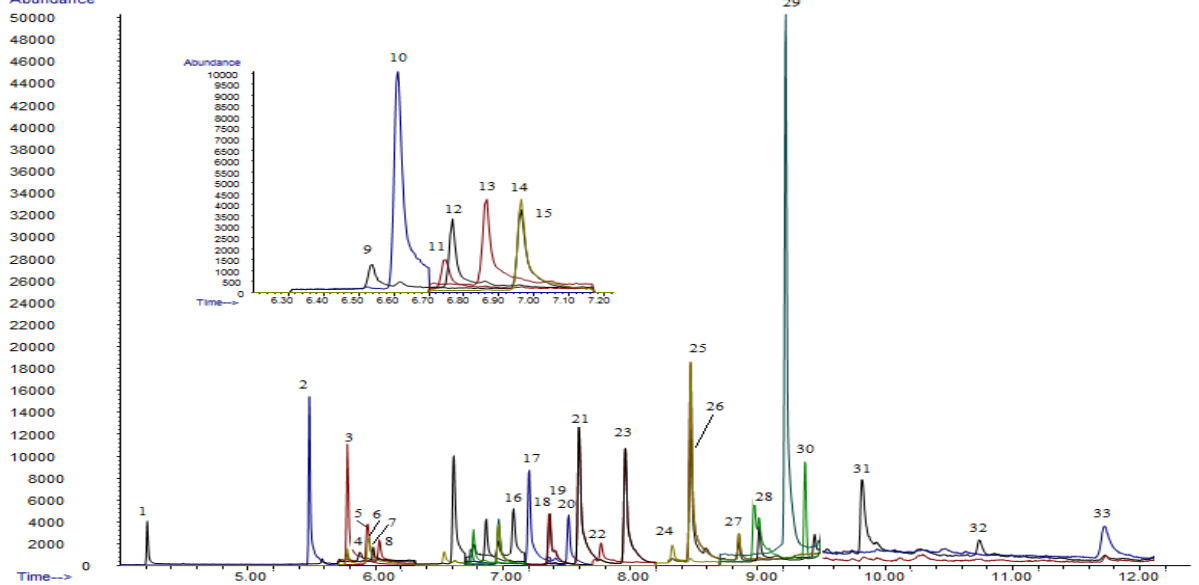
Figure 3. Figure 3. Extracted ion chromatogram of matrix-matched standards, at a concentration level of 50 µ g/L. Peak assignments are the following: 1 carbofuran, 2 trifluralin, 3 hexachlorobenzene, 4 dimethoate, 5 atrazin, 6 propazin, 7 diazinone, 8